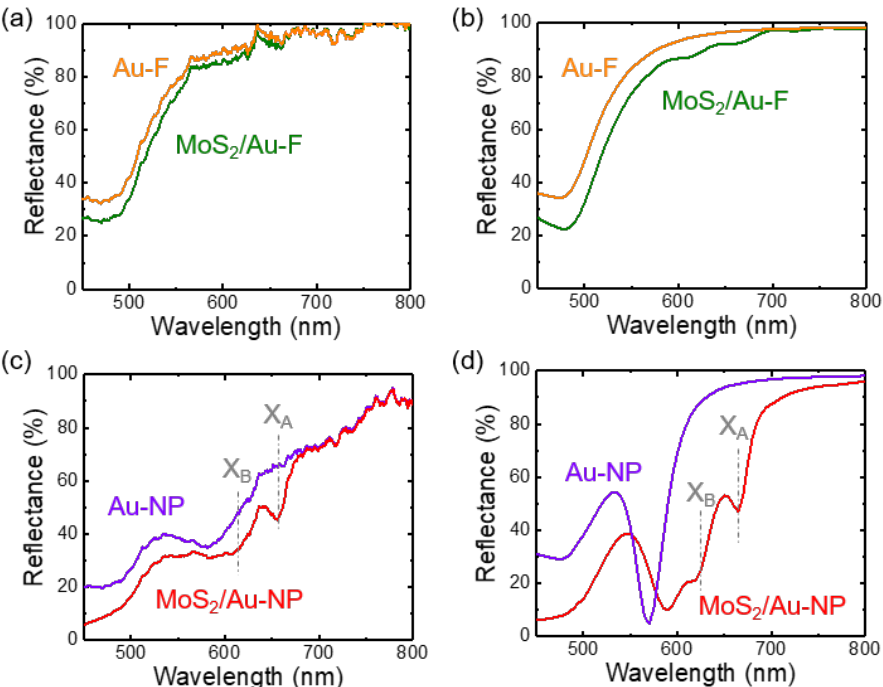
Figure 3. ( a ) Measured and ( b ) calculated reflectance spectra of Au-F (orange) and MoS 2 /Au-F (green), respectively. ( c ) Measured and ( d ) calculated reflectance spectra of Au-NP (violet) and MoS 2 /Au-NP (red), respectively. X A and X B indicate the A and B exciton wavelengths of MoS 2 monolayers, respectively.